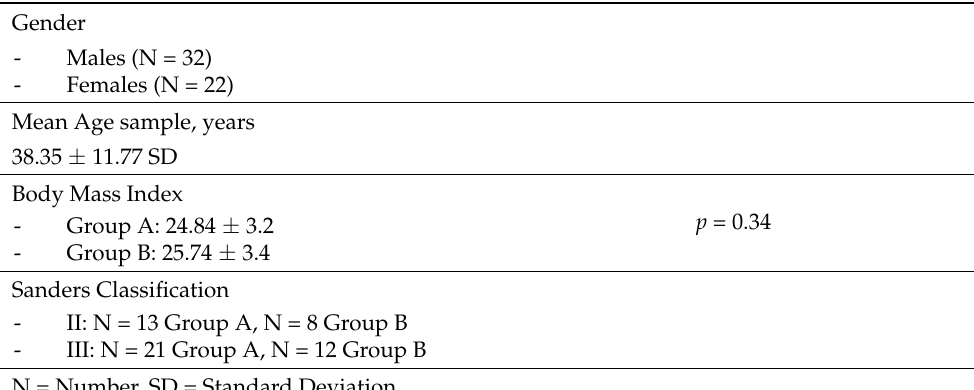
Table 3. Baseline characteristic of the sample. Figure 3. Preoperative X-ray and CT images of a Sanders Type III calcaneal fracture.